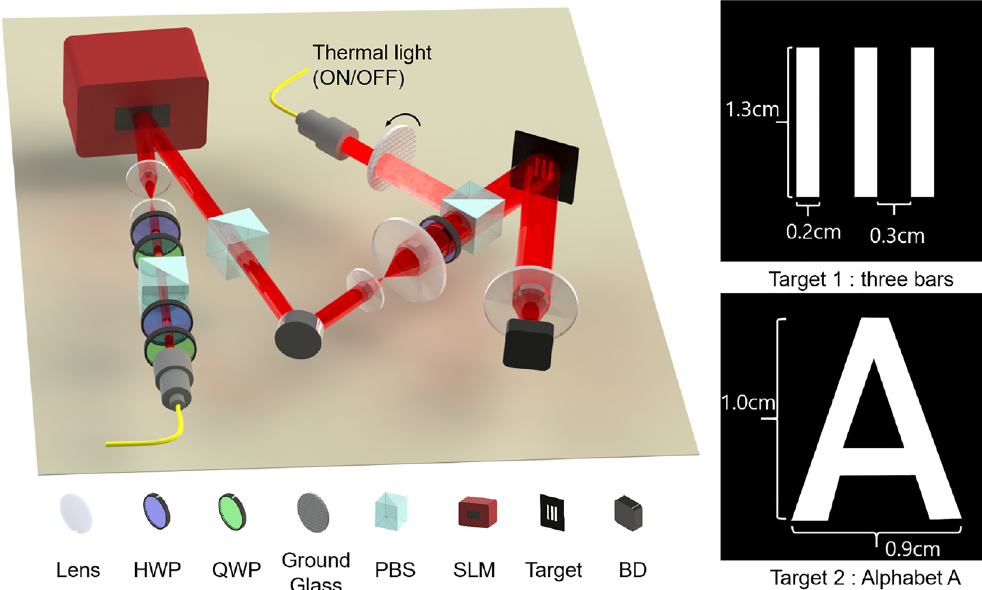
Figure 1. Experimental setup for CGI with two targets used for imaging, 3 bars and alphabet A. An H-polarized laser beam is reflected at the phase-controlling SLM. The phase-modulated beam becomes an intensity-modulated beam after the PBS. The modulated beam illuminates a target object and the intensity of received light from the target is measured by using a single-pixel bucket detector. For channel-simulated imaging, noise source is turned-off and noise-added patterns are displayed on the SLM. For the verification of our channel simulation, we turn on the thermal noise source consists of a laser and a rotating ground glass disk, and we conduct the imaging with the original Hadamard patterns. HWP half-wave plate, QWP quarter-wave plate, PBS polarizing beam splitter, SLM spatial light modulator, BD bucket